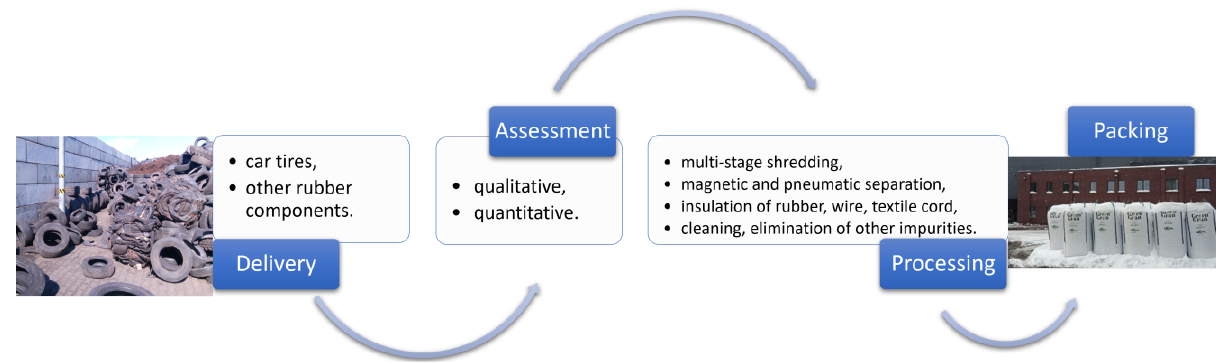
Figure 2. General overview of the process.